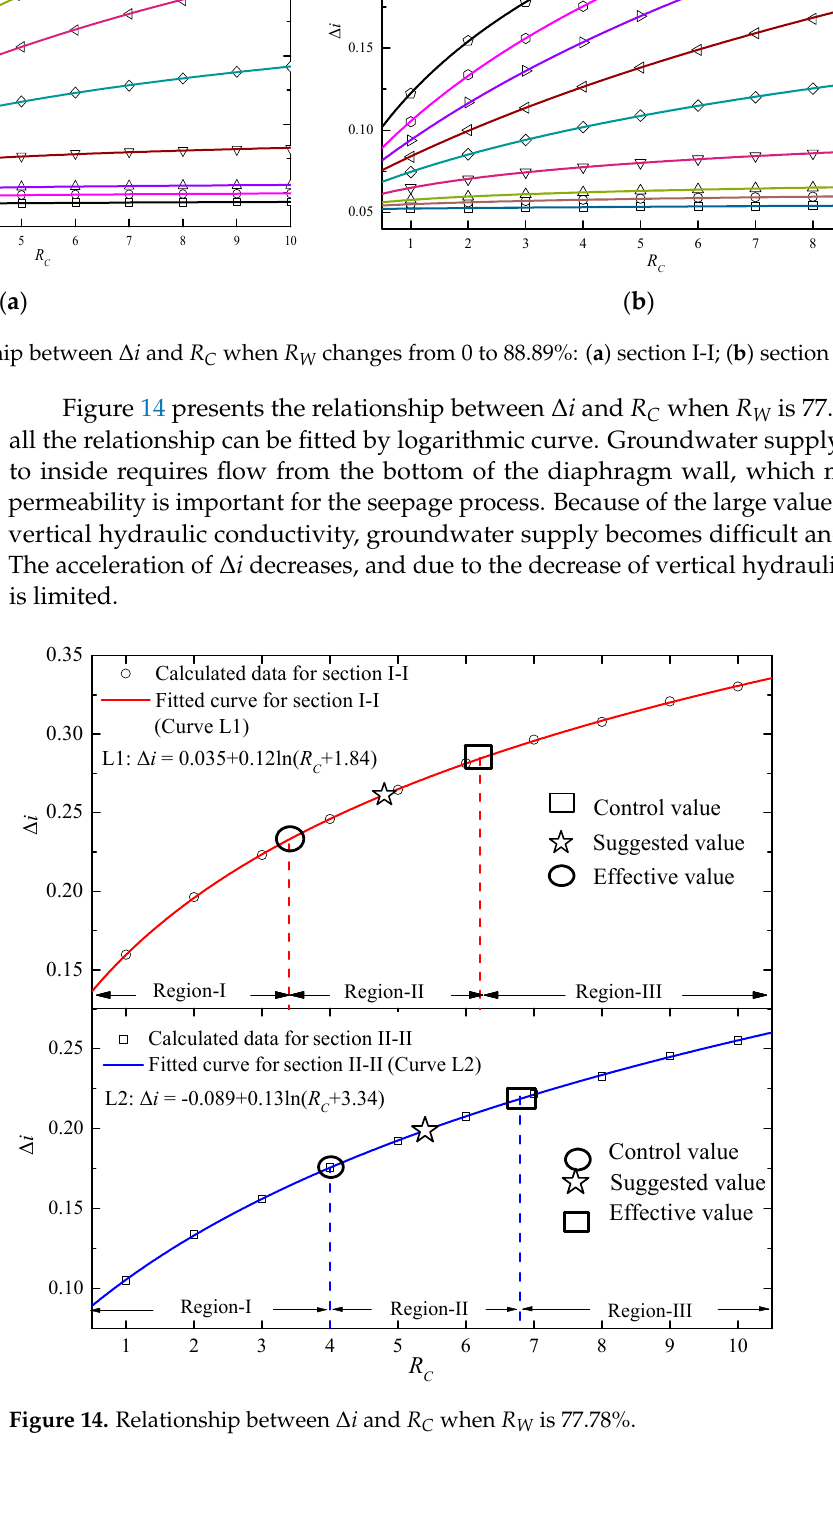
Figure 14. Relationship between ∆ i and R C when R W is